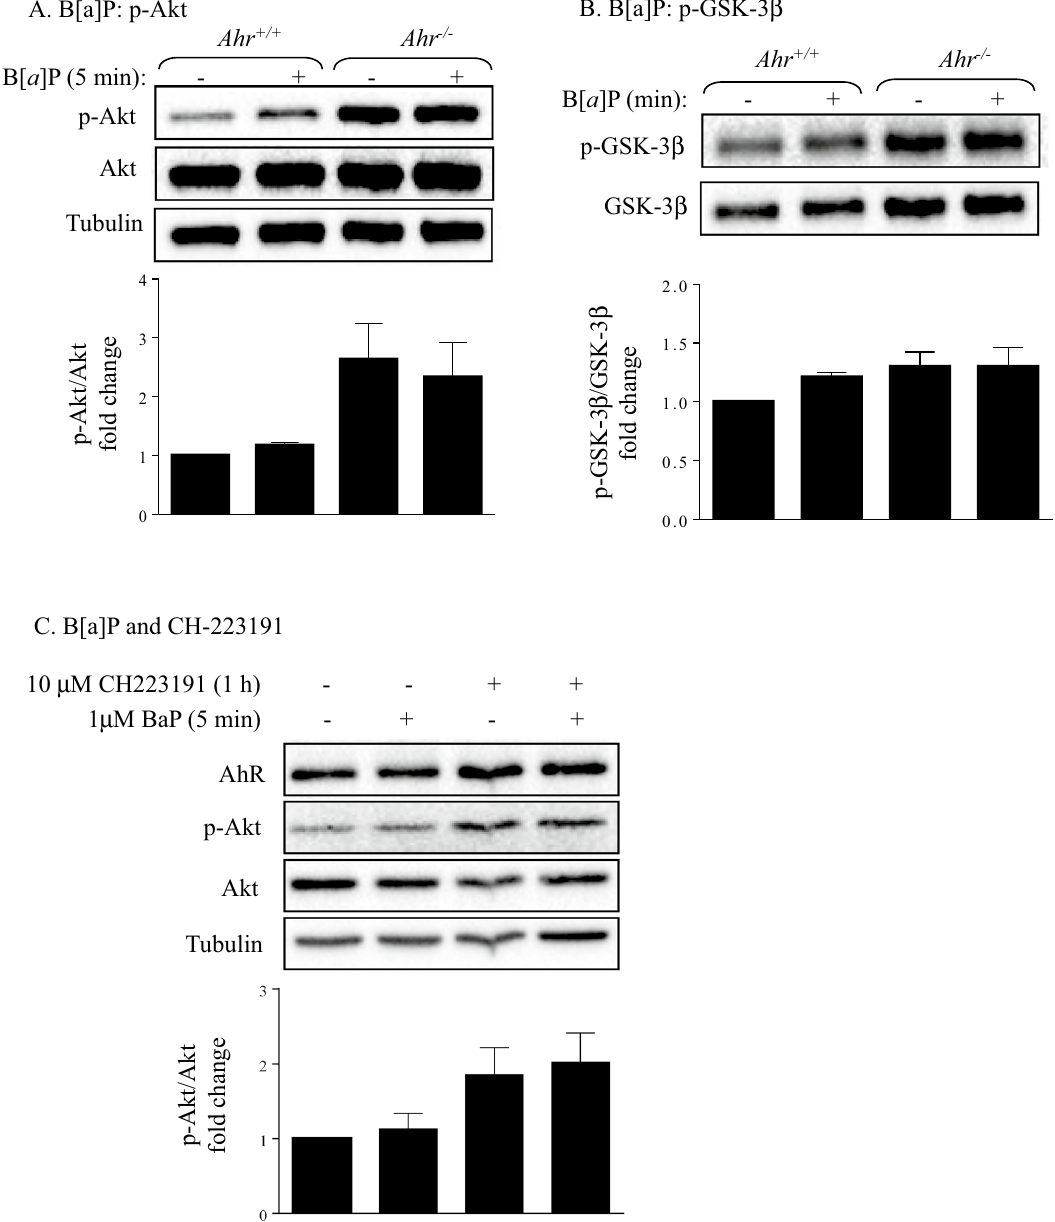
Figure 3. Effect of AhR activation on Akt and GSK-β phosphorylation . ( A , B ) Serum-starved Ahr +/+ and Ahr −/− MLFs were either treated with 1 μM B[ a ]P or the vehicle control (DMSO) for 5 min and cellular protein was collected for western blot analysis of ( A ) Akt and ( B ) GSK-3β phosphorylation. ( C ) Serum-starved Ahr +/+ MLFs were treated with 10 μM CH-223191 or DMSO for 1 h followed by 5 min co-treatment with 1 μM B[ a ] P or DMSO and cellular protein was collected for western blot analysis of Akt phosphorylation. Blots are representative of ( A , B ) three or ( C ) five independent experiments. Densitometric values of the phosphorylated proteins were normalized to the values of their corresponding total proteins and were converted to fold changes relative to that of the control Ahr +/+ cells. Results are expressed as mean ±